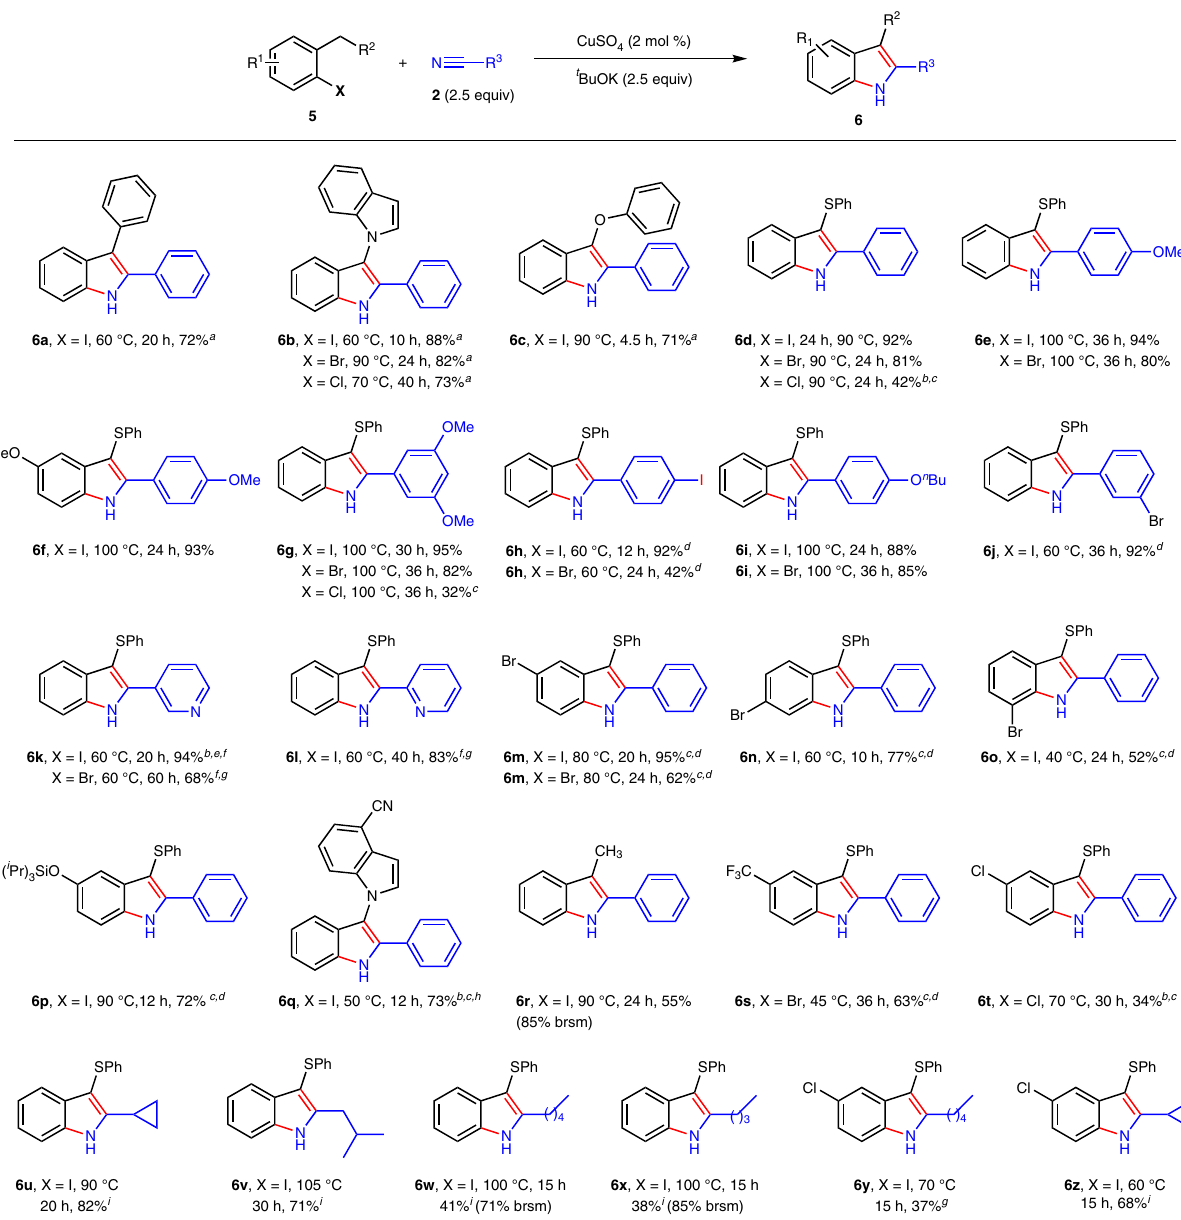
completion of the starting materials, the reaction mixture was directly puri fi ed by silica gel column to give the desired product.